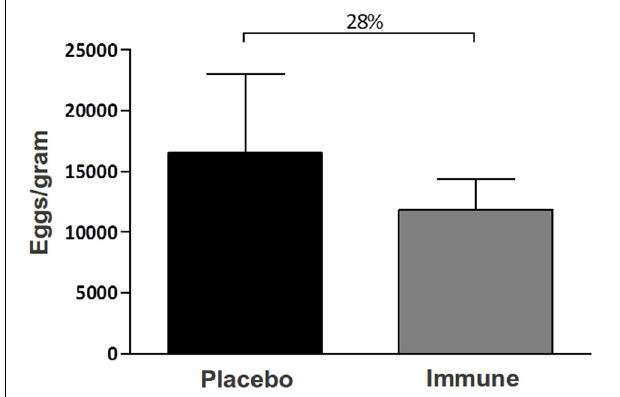
FIGURE 4 | Counting of the number of S. mansoni eggs retained in the liver of immunized mice. The number of S. mansoni eggs in 10 mice immunized with Tris-NaCl + adjuvant (placebo group) or with rSMYB1 + adjuvant (immune group) were counted. The infection developed for 45 days prior to sacrifice. The liver was digested for 48h in a 5% KOH solution (p/v), and the eggs were maintained in 10% buffered formaldehyde until counting. The results are presented as the mean number of eggs per gram of liver. No statistically significant differences were observed between groups ( p > 0 . 05). The results are representative of two independent biological